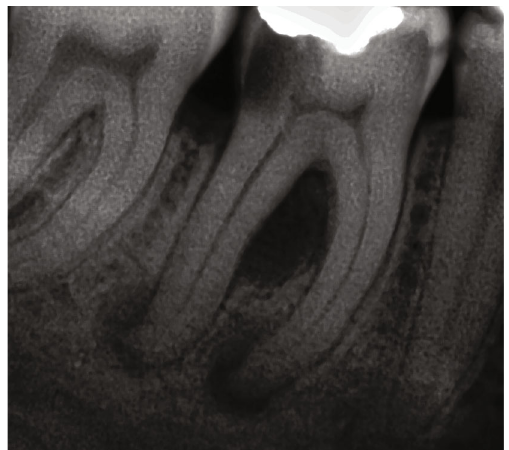
Figure 2: Apical radiograph of tooth # 46. Isolated furcation bone and apical bone destruction in the mesial and distal roots.